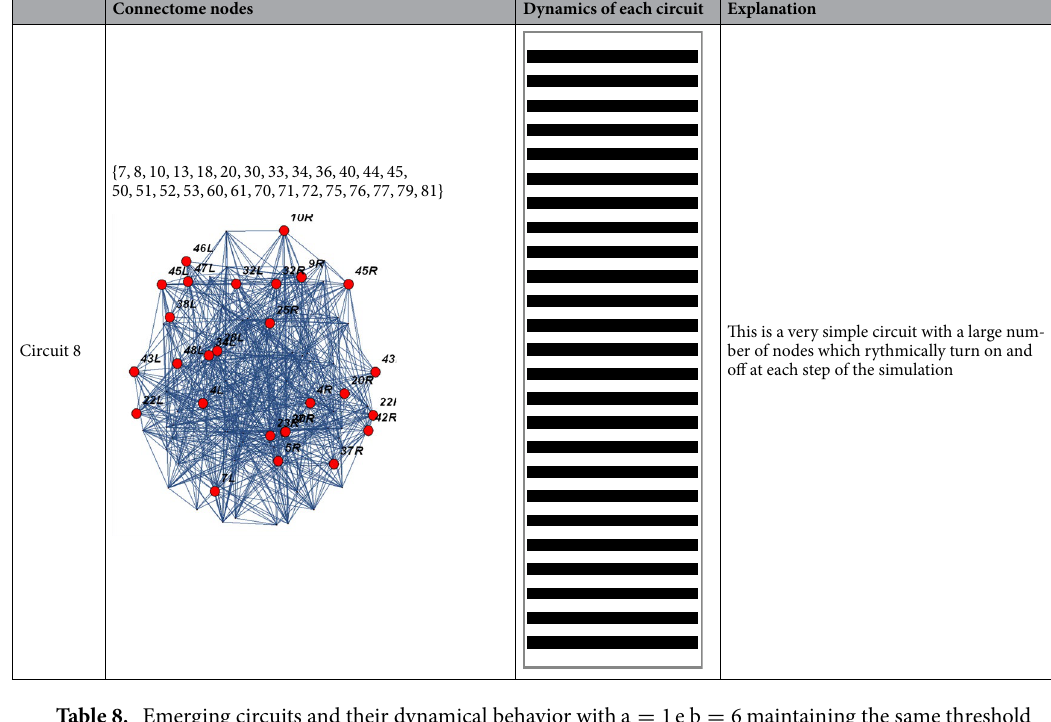
Table 8. Emerging circuits and their dynamical behavior with a = 1 e b = 6 maintaining the same threshold x = 0.9